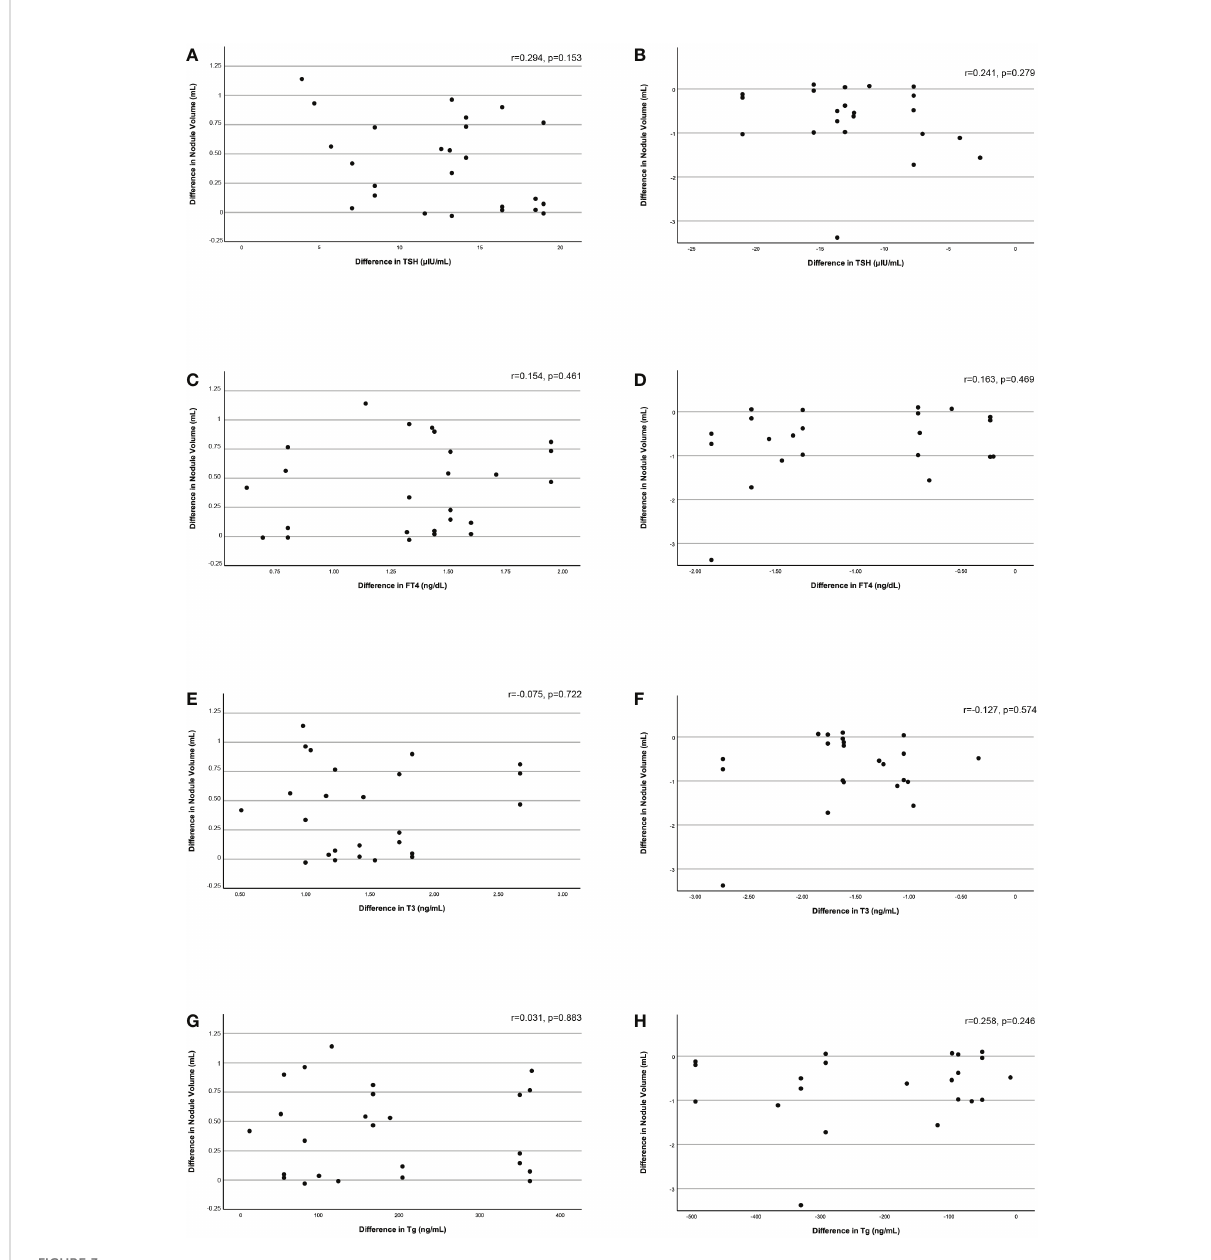
FIGURE 3 Correlation of the difference in nodule volume between baseline and 48 hours and between 48 hours and 6 months with the respective difference in serum TSH (3A, 3B) , FT4 (3C, 3D) , T3 (3E, 3F) , and Tg (3G, 3H)